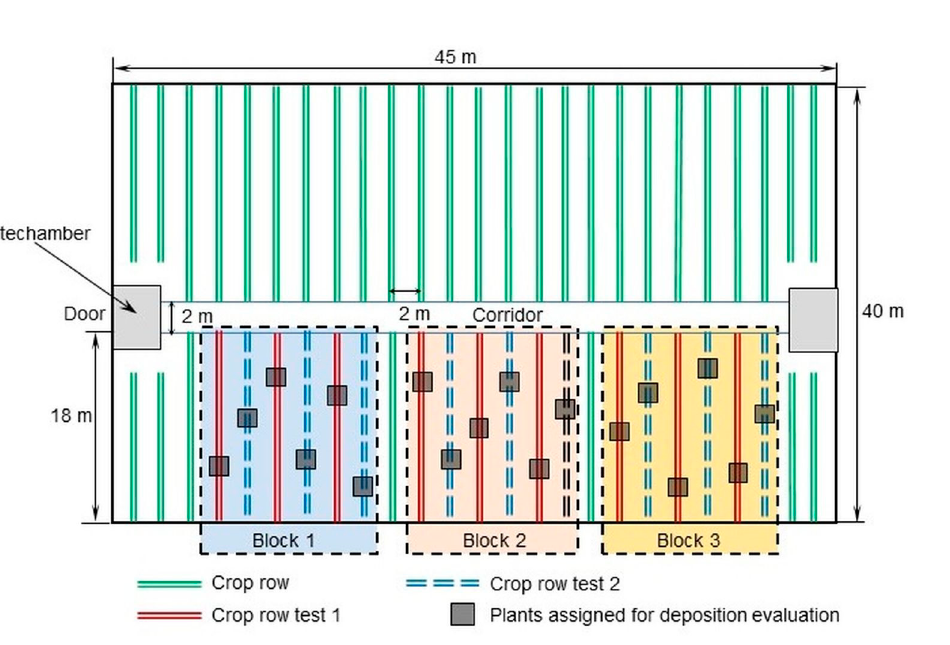
Figure 3. Floor plan of the greenhouse indicating the sampling blocks for the experimental plants.